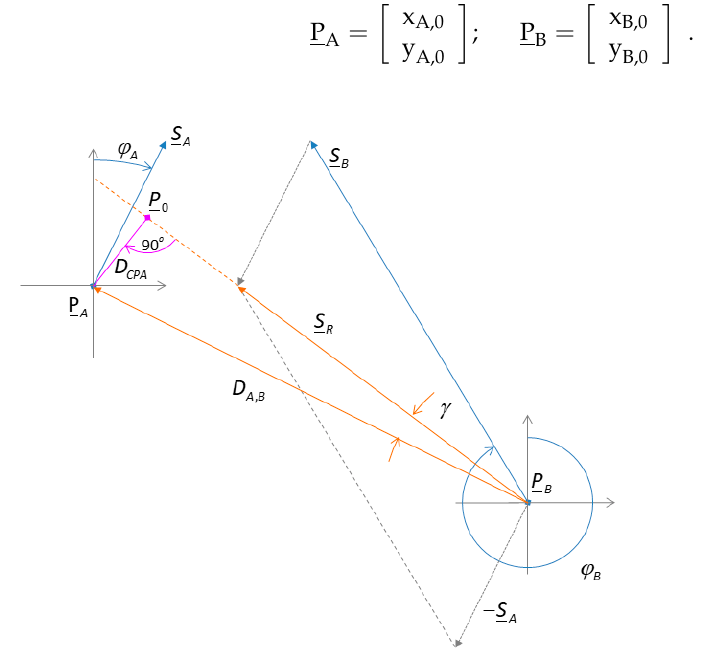
Figure 7. Relative data-based representation of ship encounters (the parameters are detailed in the text).